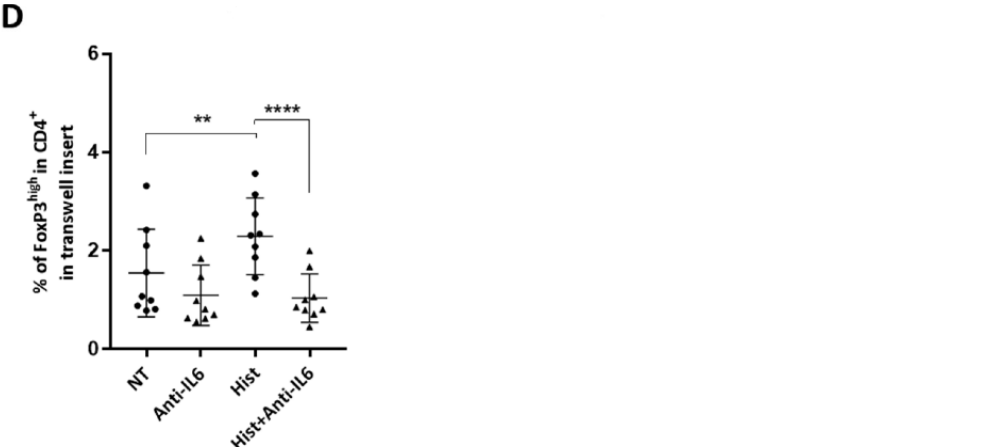
Figure 4. IL-6 and ICAM-1 are implicated in the mechanisms of Treg expansion in this model of endothelial cell activation by histones. ( A ) HMECs pre-treated with histones for 18 h were washed and treated with 10 ng/mL anti-IL-6 neutralizing antibody prior to adding PBMC. PBMC were stained after three days of co-culture to evaluate Treg expansion as described above. Results are presented as percentage of CD4 + CD25 + CD127 low FoxP3 high among CD4+ cells. Histone pre-treatment increased Treg expansion (Paired t -test, *** p = 0.0002, n = 30), and this was reduced after IL-6 blockade